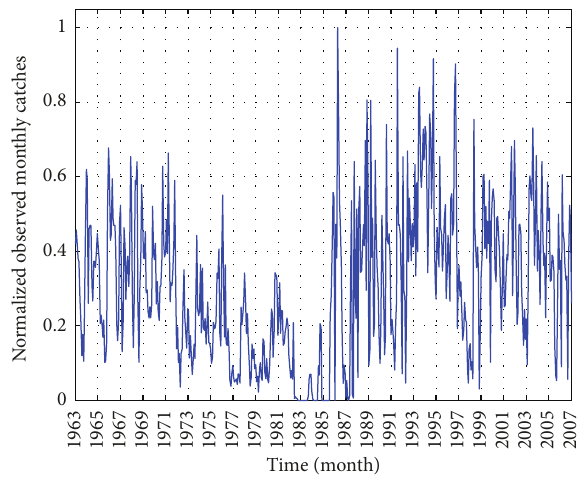
Figure 1: Observed monthly anchovy catches data.